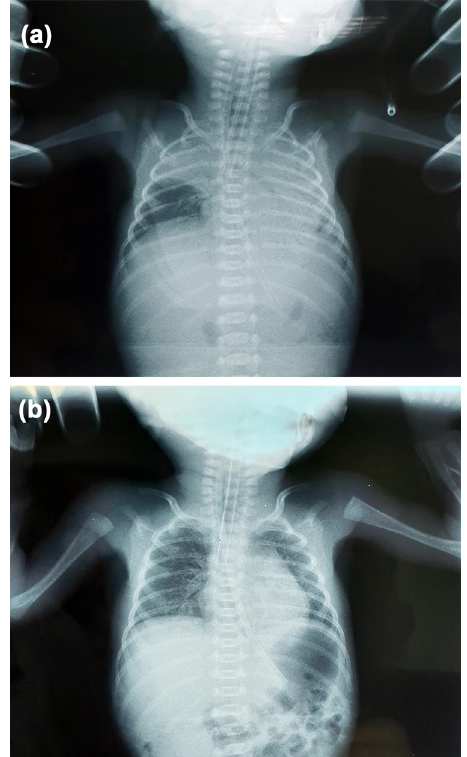
Figure 1: Chest X - ray of the newborns. ( a ) Image shows decreased transparency of the pulmonary parenchyma to the left with a clearly limited presence in the upper lobe area to the right in the fi rst newborn; ( b ) chest X - ray shows individual paracardial and basal shadings of the pulmonary parenchyma in the second